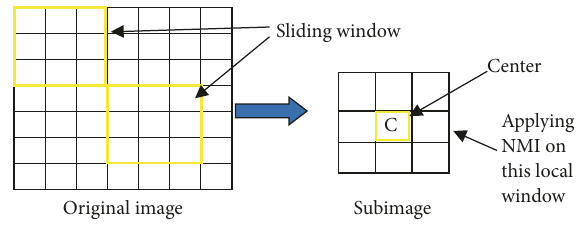
Figure 1: Basic concept of sliding window